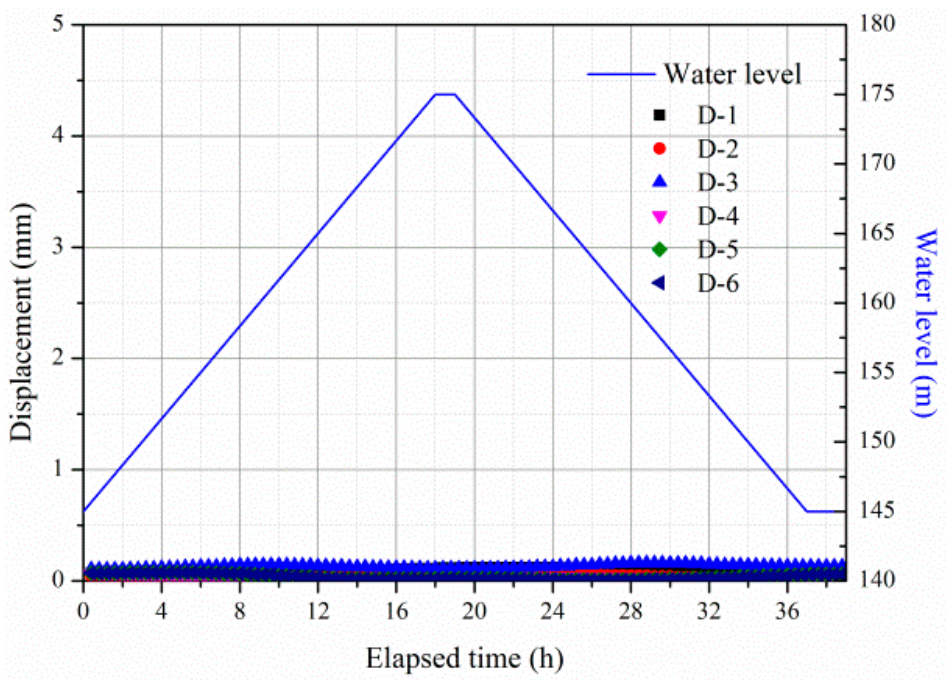
Figure 12. Displacements observed during the rising and lowering of the water levels.